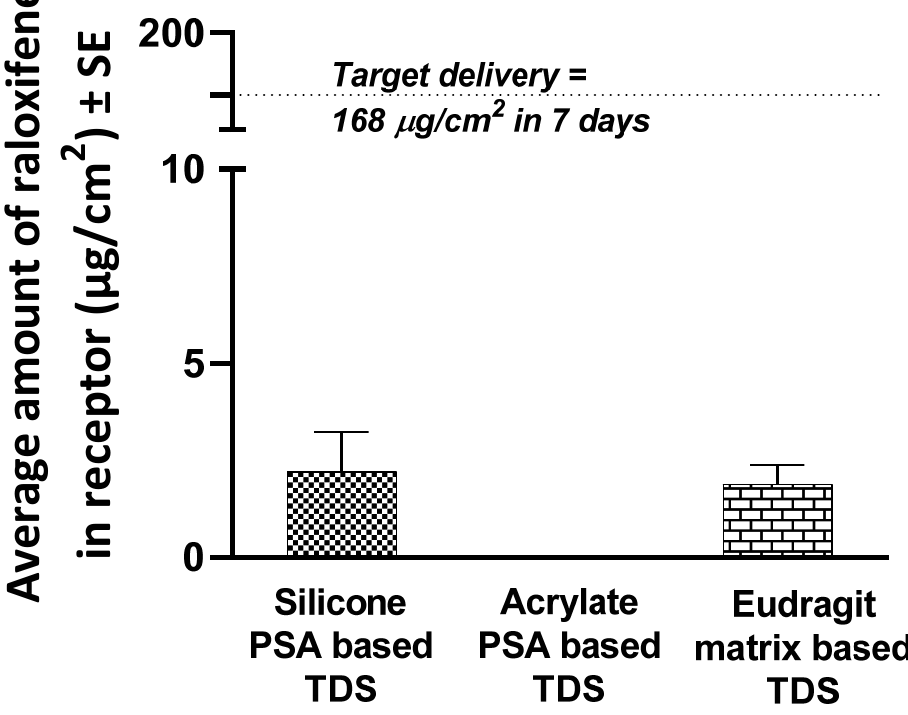
Figure 3. Total amount of raloxifene delivered into the receptor from ( a ) PSA-based TDS and ( b ) polymeric Eudragit-based TDS, n = 4.